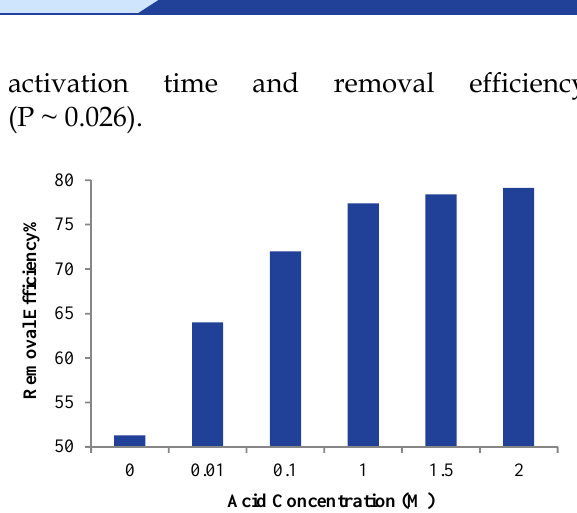
Figure 2. Effect of acid concentration on cyanide removal [cyanide: 30 mg/l, unadjusted pH]